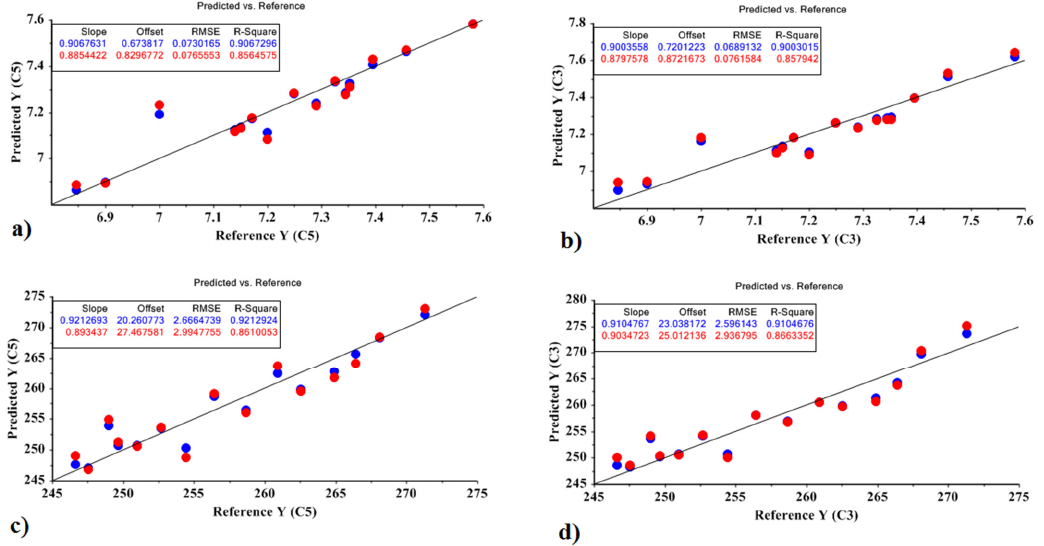
Figure 6. MLR prediction models for predicting the amount of carbohydrate and sugar in the Sante cultivar: ( a ) the amount of sugar based on the PCR method; ( b ) the amount of sugar based on PLSR method; ( c ) the amount of carbohydrate based on the PCR method; ( d ) the amount of carbohydrate based on the PLSR method. Molecules 2022 , 27 , x FOR PEER REVIEW X3 and X4 were not significant at the 0.01 level, so they were deleted in the model. The values obtained for the model were R 2 = 0.856 and RMSE = 0.076; p < 10 − 4 .